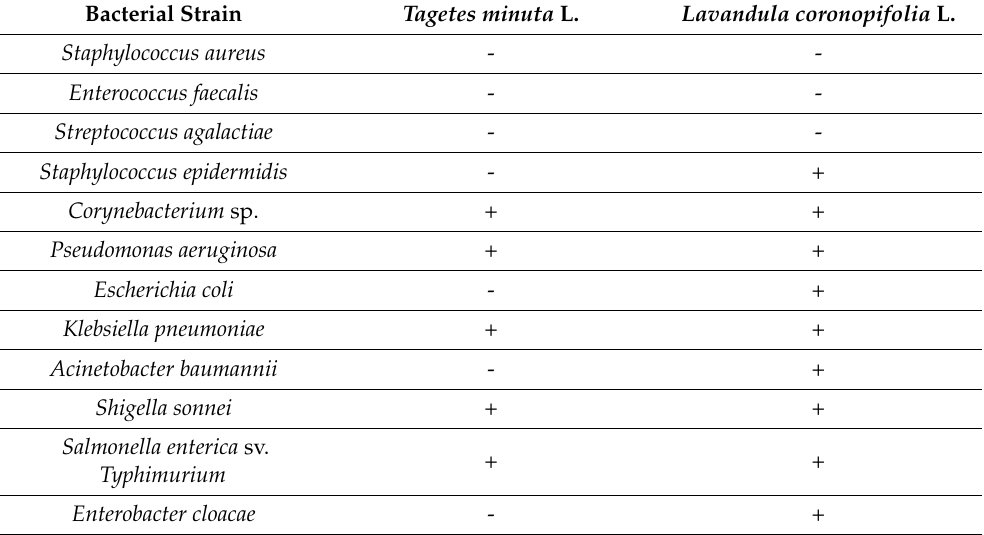
Table 4. Antibacterial activity of the essential oils of Tagetes minuta L. and Lavandula coronopifolia